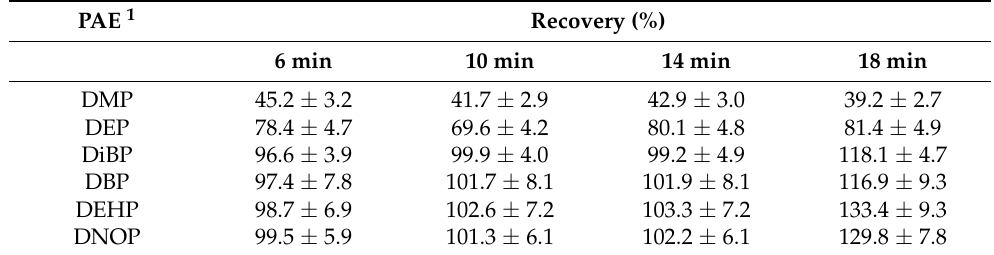
Table 4. Recoveries (%) of each phthalate based on the sonication times in the ultrasonic bath. PAE 1